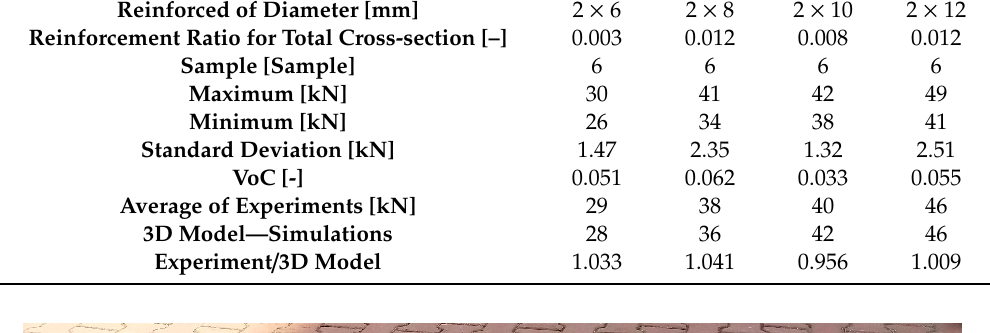
Reinforcement Ratio for Total Cross-section [–]